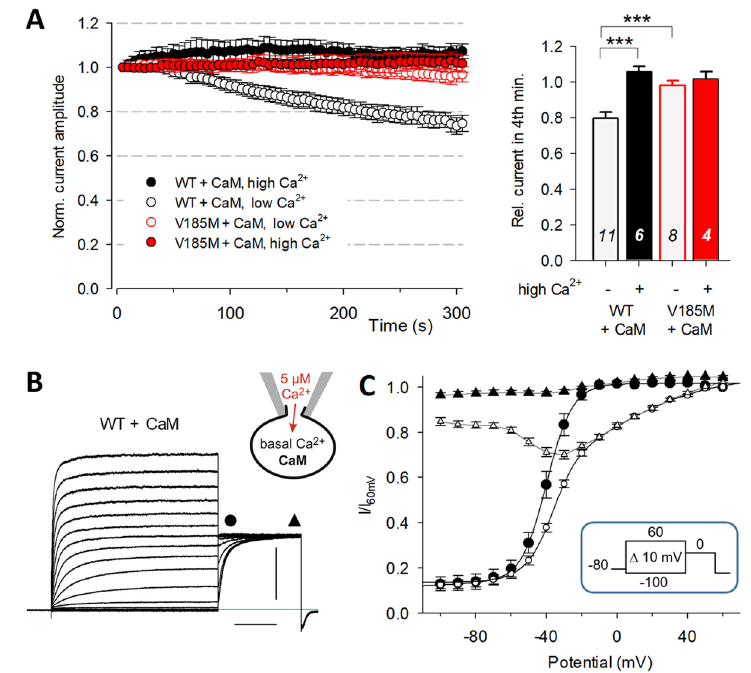
Figure 3. In cells co-expressing calmodulin (CaM), high intracellular Ca 2+ abolishes early current run-down and characteristic WT KCNQ1 properties. Whole-cell recordings were performed with different Ca 2+ concentrations of ICS in CHO cells expressing the KCNQ1 channels, together with CaM. ( A ) Time course of current amplitudes traced with a 500 ms test pulse to 40 mV. Mean normalized current amplitudes for WT and V185M-KCNQ1 channels from experiments with standard low-Ca 2+ ICS and high-Ca 2+ (5 µM) ICS. Numbers of experiments are given in the bar plot, which shows mean (+SEM) relative current amplitudes after 3.5 to 4 min. Asterisks indicate significant differences; *** p < 0.001. ( B ) Example of WT KCNQ1 current traces, recorded in a cell co-expressing CaM > 5 min in whole-cell configuration using 5 µ M-Ca 2+ ICS. Scale bars denote 1 nA and 500 ms. ( C ) Mean ( ± SEM; n = 7) normalized instantaneous P2 current amplitudes (GV relation, filled circles) and current amplitudes measured at the end of the 1 s P2 pulse to 0 mV (filled triangles) are plotted against the P1 potential. Filled symbols: data for WT KCNQ1 channels co-expressed with CaM and recorded with high-Ca 2+ ICS, as shown in ( B ). Open symbols: data of seven closely paralleled control experiments on WT KCNQ1 without CaM co-expression using standard low-Ca 2+